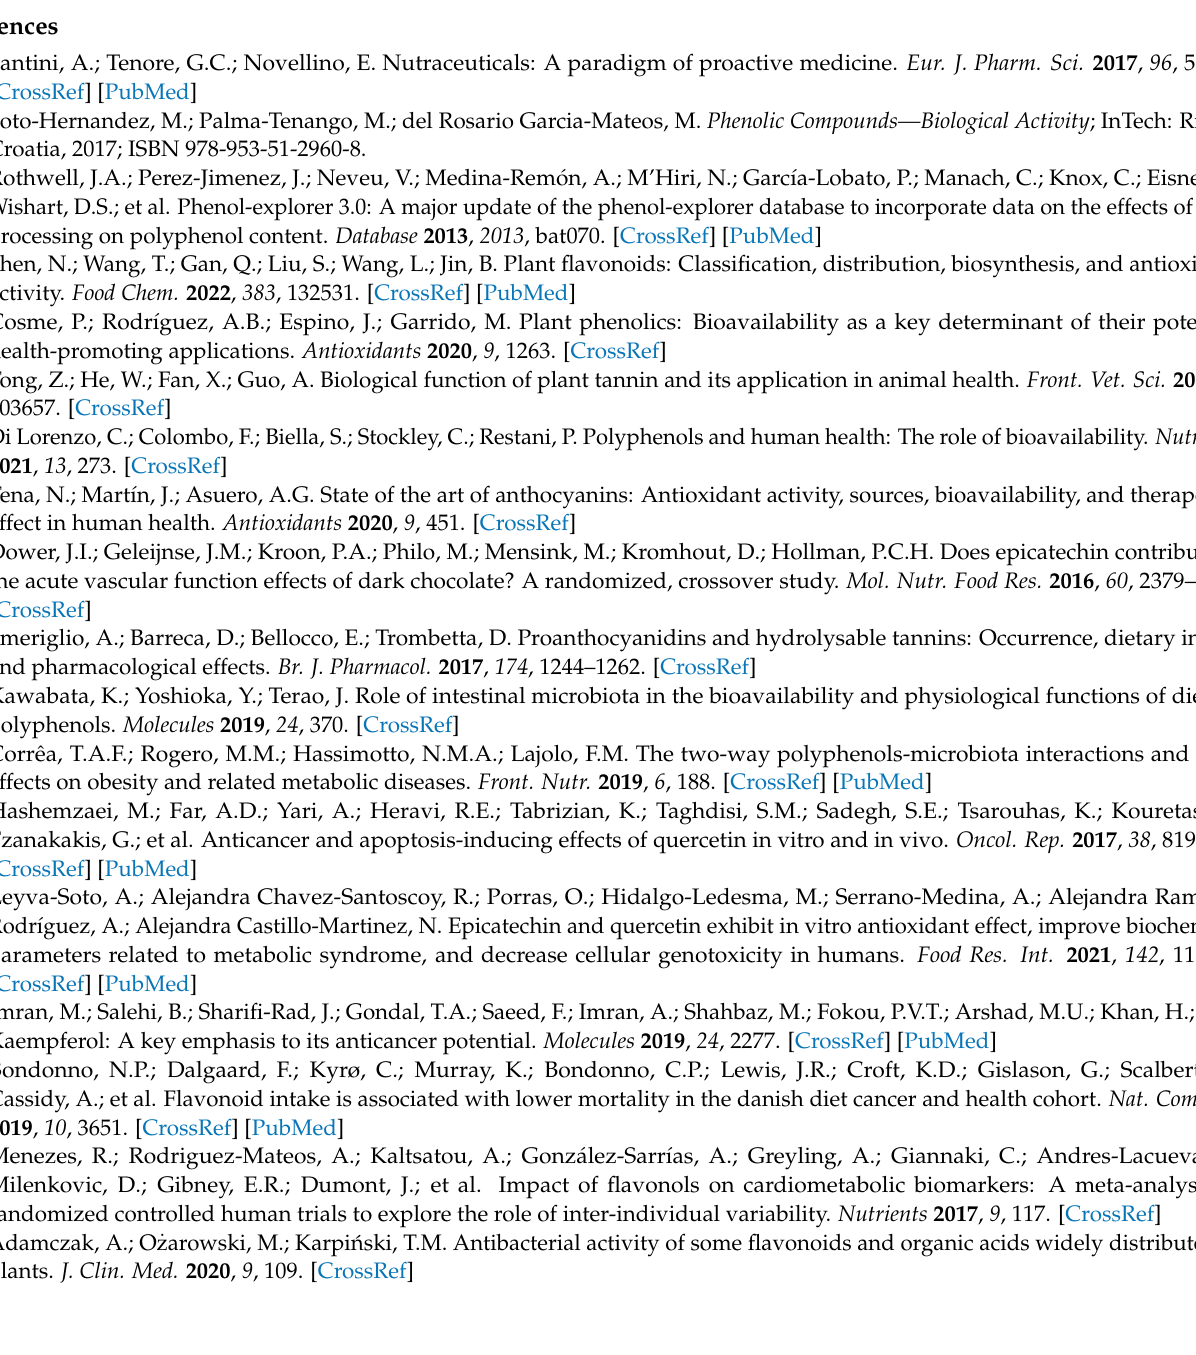
derived phenolic metabolites; Figure S3: Chemical structure of tannins; Table S1: Summarized information of cited in vitro and in vivo